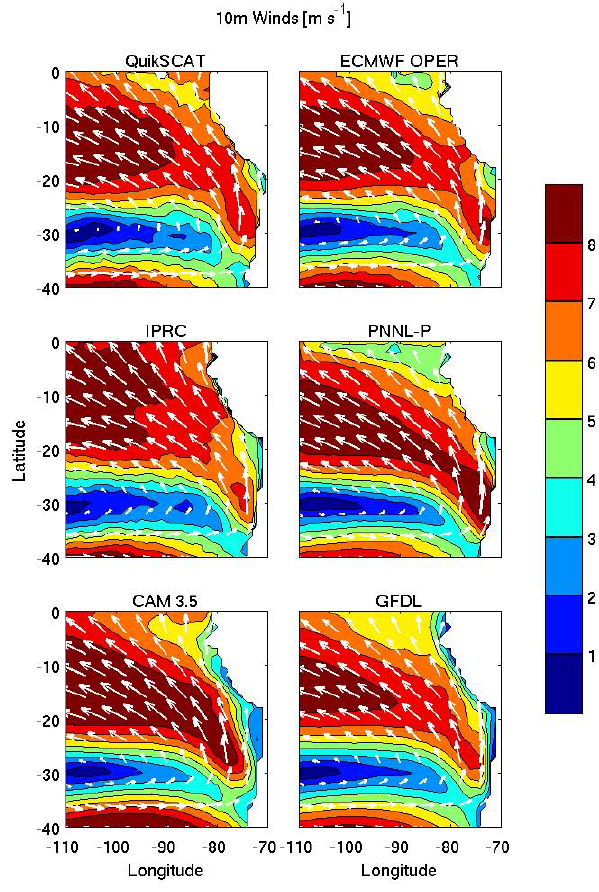
Fig. 2. October 2006 mean 10-m wind speed (ms − 1 ) and wind vectors for QuikSCAT (upper left) and a selection of